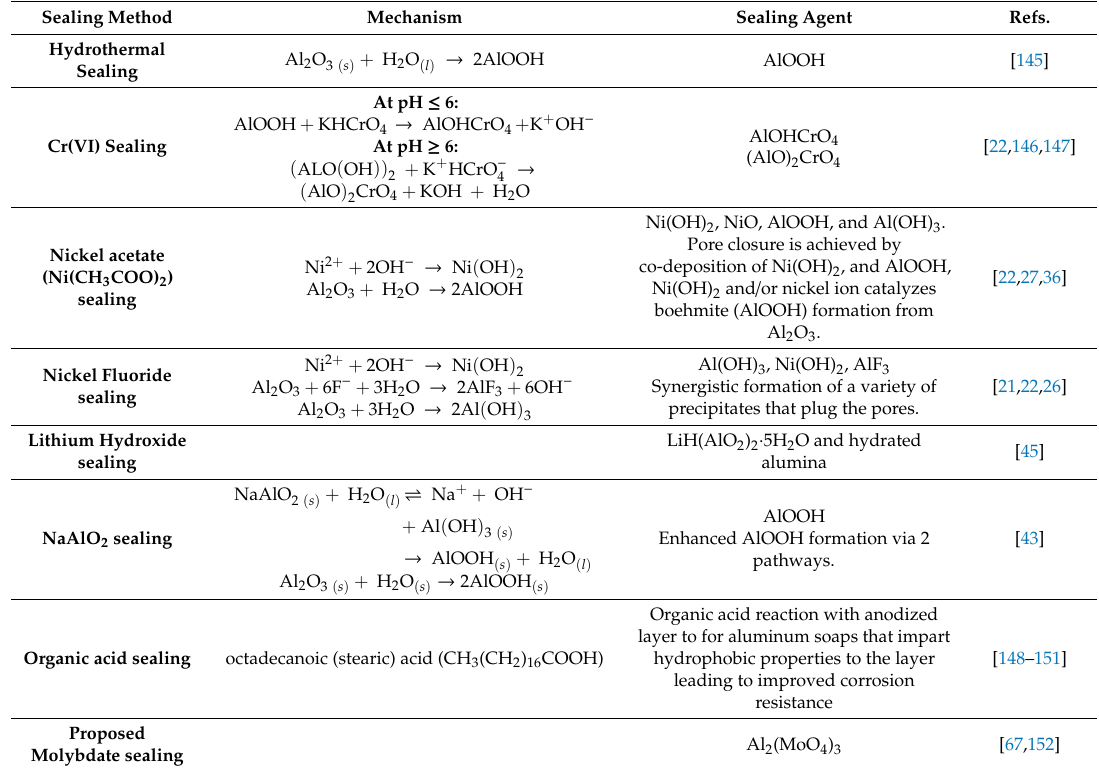
Table 3. Table of di ff erent proposed sealing mechanism for anodized